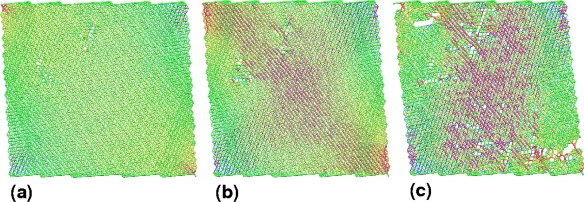
Quasi-static shear loading of a virtual material specimen with N = 2500. The color code is the same as in Figure 28 except for particle bonds under pressure which are coded in blue. (a) Onset of shear tensile bands and (orthogonal) shear pressure bands in the corners of the specimen. (b) Shear bands traversing the whole specimen. (c) Ultimate failure.